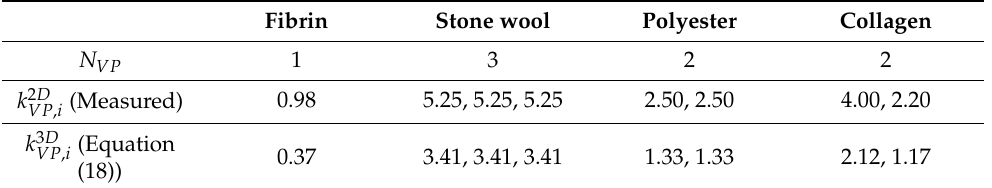
Table 1. Fitted parameters for experimental fiber orientation distributions and corrected 3D orienta- tion strength parameters. Fibrin Stone wool Polyester Collagen N VP 1 3 2 2 k 2 D VP , i